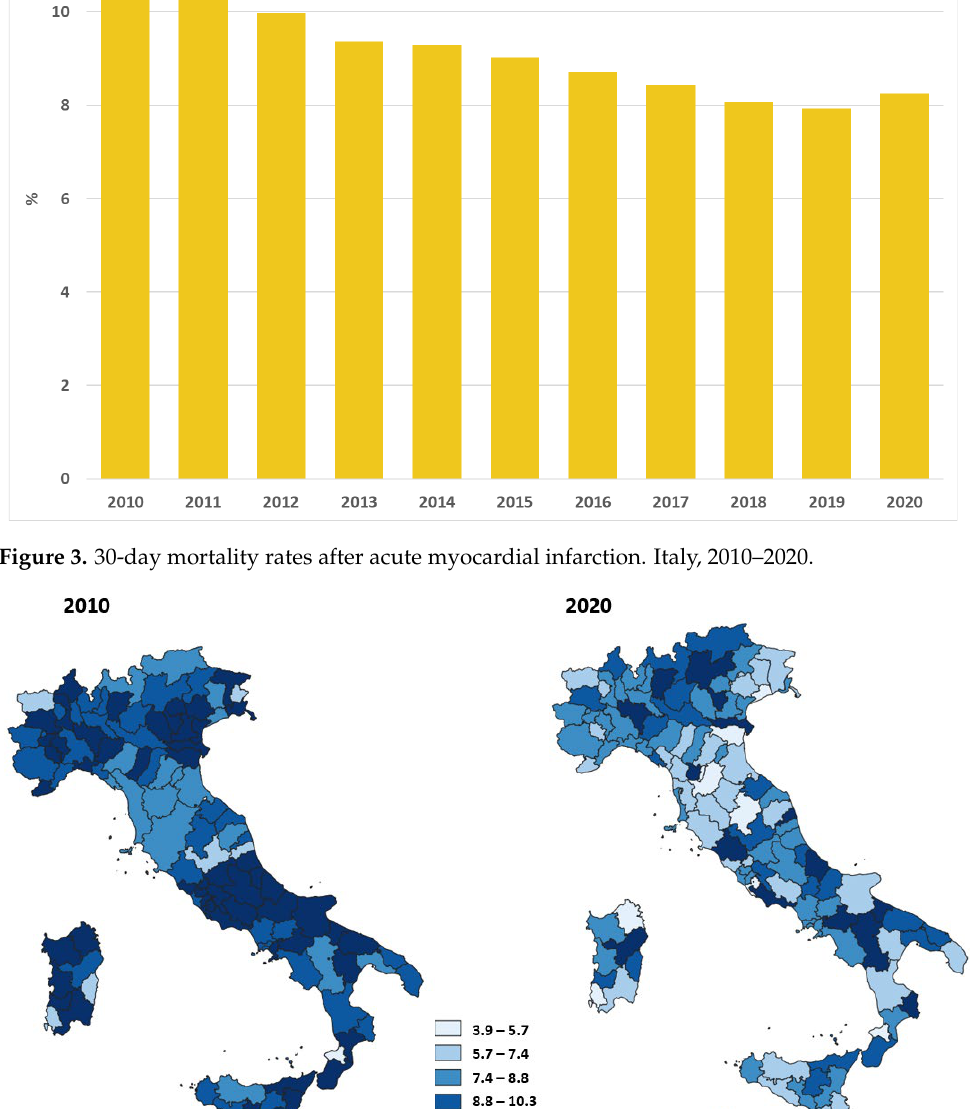
Figure 4. Adjusted 30-day mortality rates after acute myocardial infarction for Italian area of residence in 2010 and 2020.